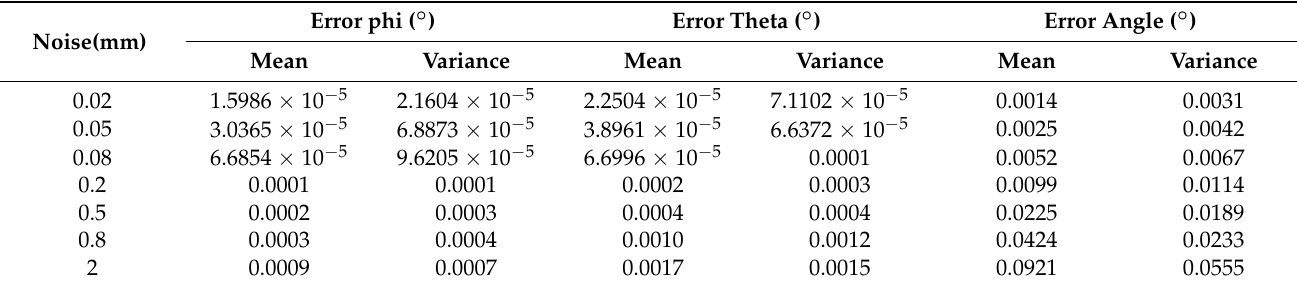
Figure 16. Errors of angles. ( a ) yaw angle; ( b ) pitch angle; ( c ) the included angle. Table 2. Statistics of error mean and variance of two-axis attitude.